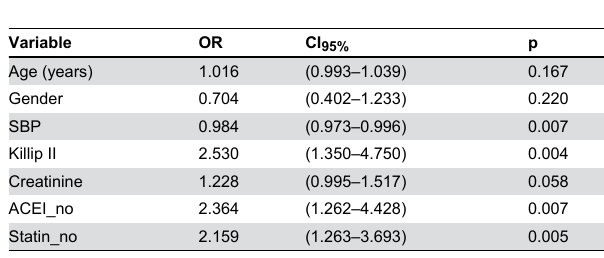
Table 2. Univariate regression analysis for the primary outcome “beta-blocker intolerance”.